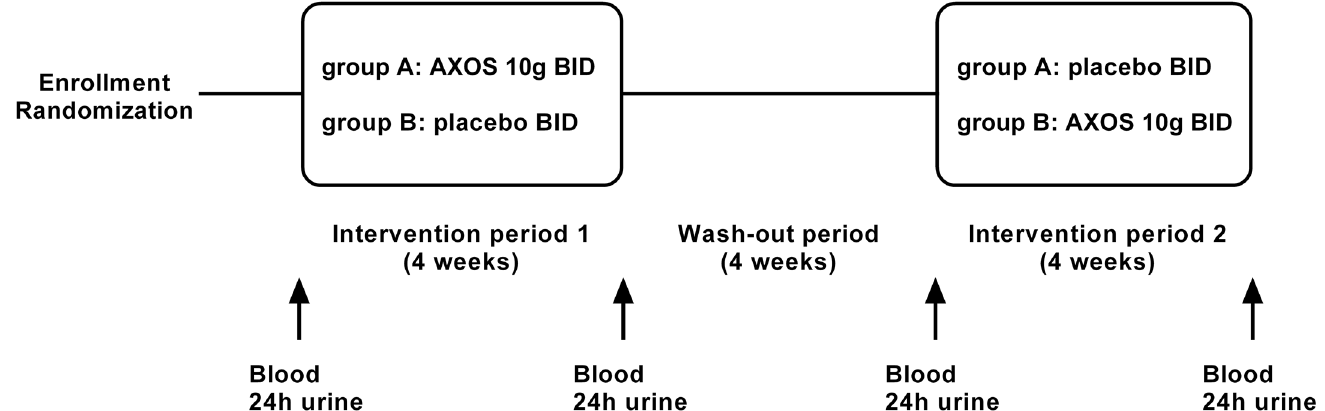
Fig 2. Study design. Schematic representation of the study design. AXOS, arabinoxylan oligosaccharides; BID, twice a